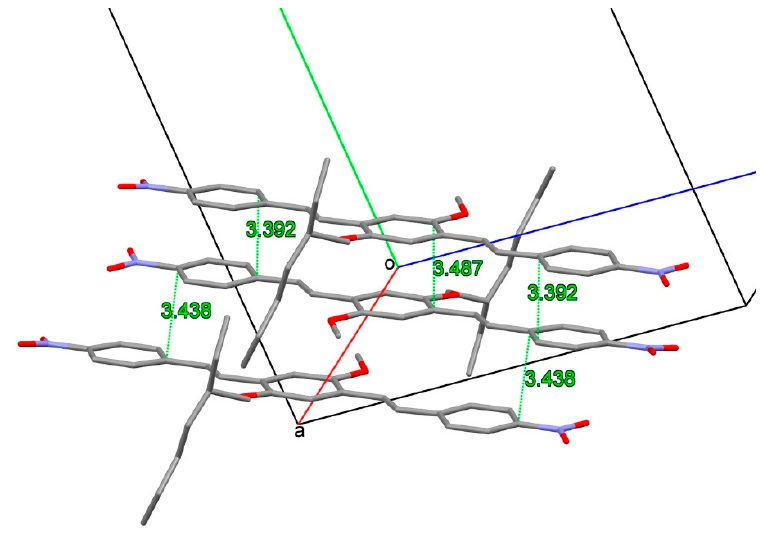
Figure 6. Partial packing showing the slipped stacking of molecules of C1 in the a axis direction. Shortest distances are drawn as green dashed lines.